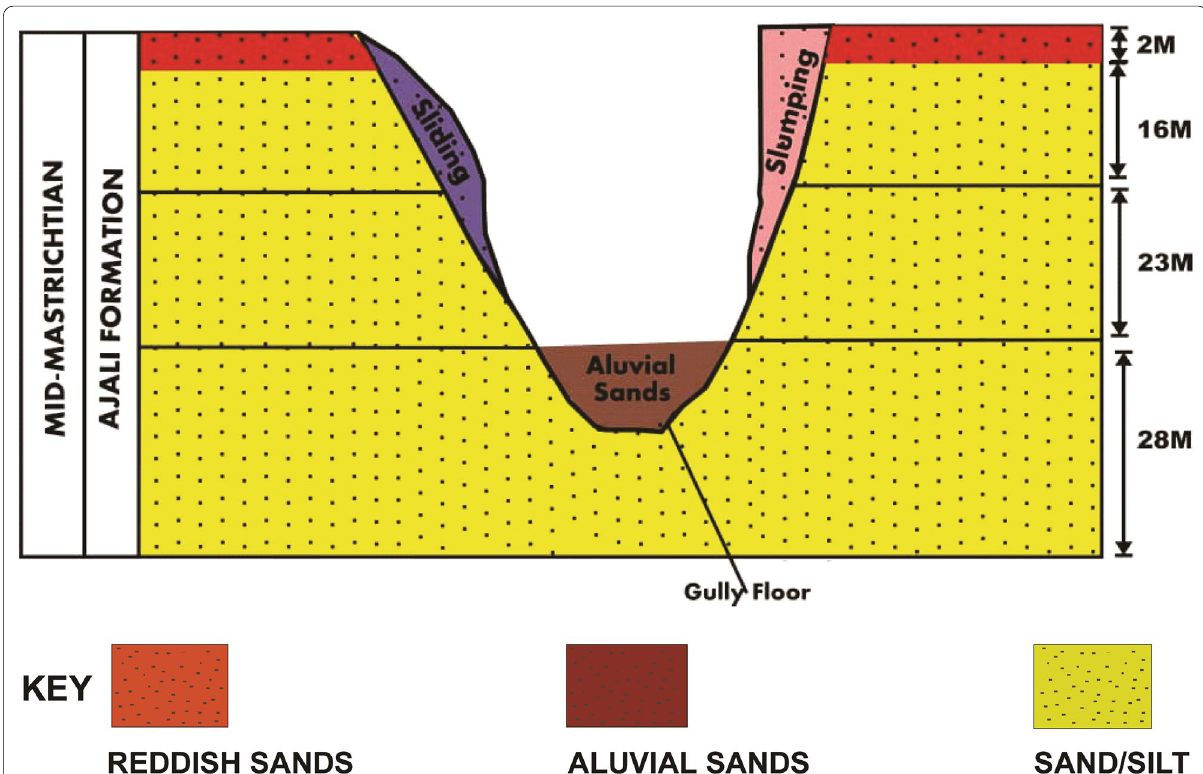
Fig. 11 Convex gully erosion model displayed in the majority of the affected areas where Ajali Formation outcropped in the study